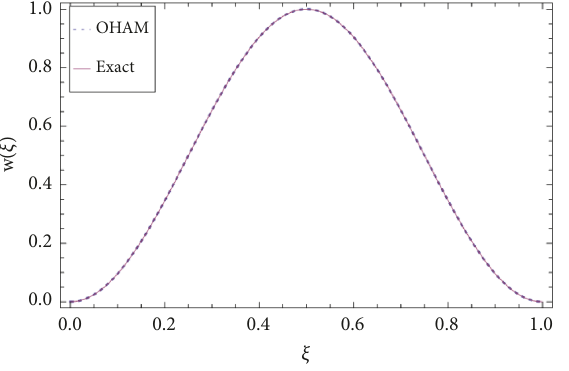
Figure 4: Comparison between exact solution (dashed line) and approximate solution (dotted line) for example